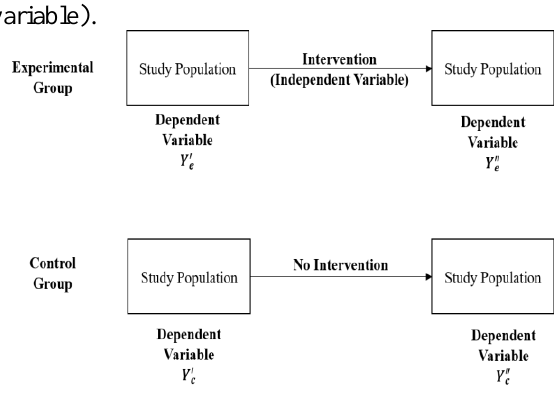
Figure 3. Control group experimental